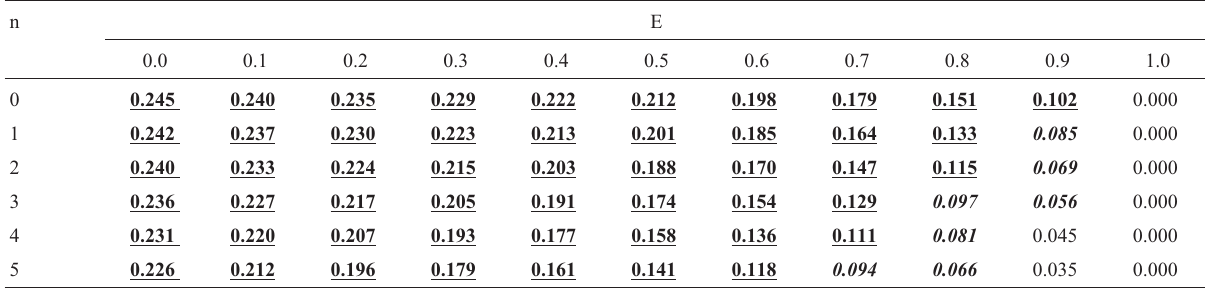
Table 5 - Recurrence risks for a sib of an isolated case, with consanguineous parents and F = 1/32 (first-degree once removed cousins), in function of the rate of environmental cases (E) and of the number of normal sibs (n = n m + n f ) that the affected child already has. n